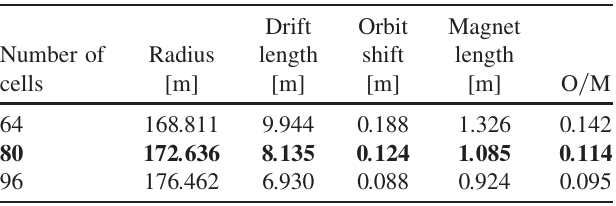
TABLE V. Geometrical lattice parameters as a function of number of cells for a 20 : 92 GeV =c machine, that is a kinetic energy of 20 GeV for a proton.